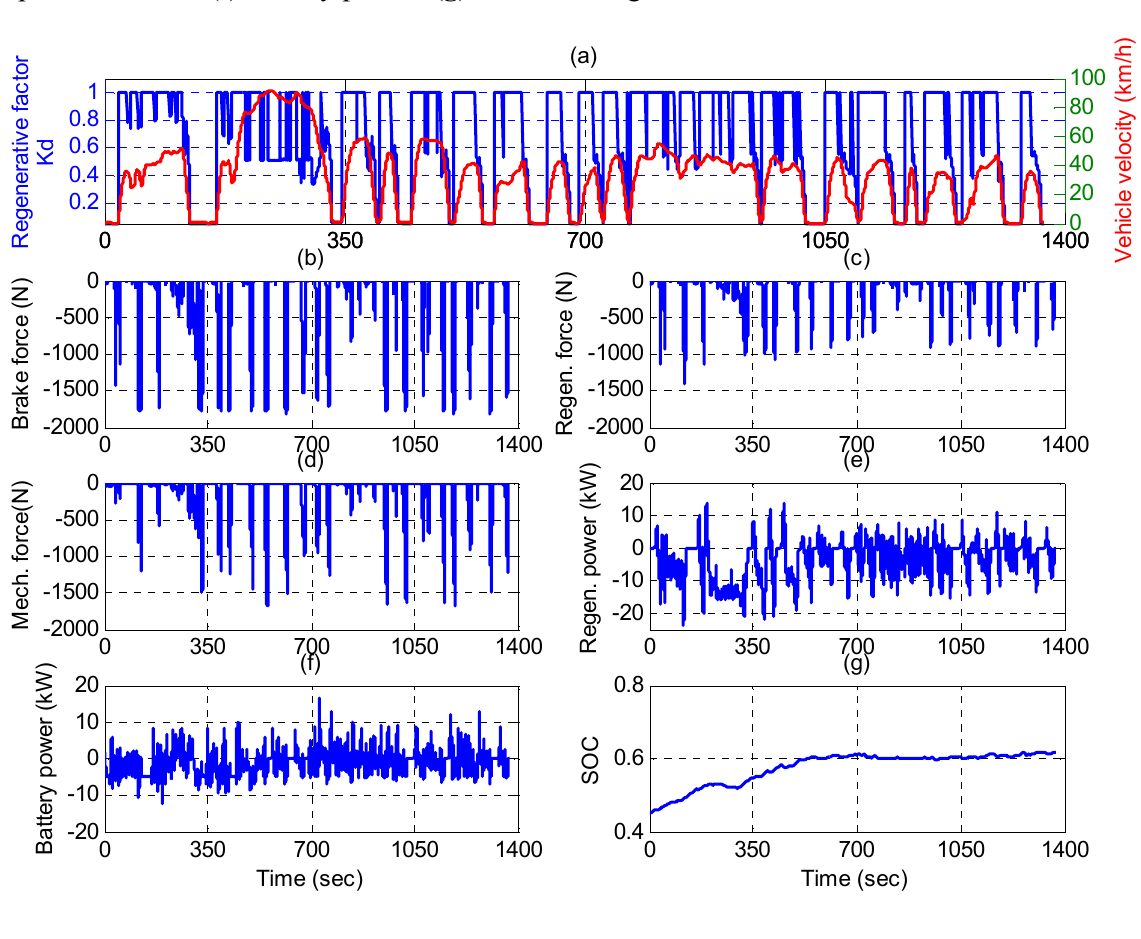
Figure 14. Simulation results of the FL regenerative braking controller for the PM-EVT-HEV during a UDDS: ( a ) UDDS and the regenerative factor; ( b ) Total braking force; ( c ) Regenerative force by EM2; ( d ) Mechanical braking force; ( e ) Regenerative power of EM2; ( f ) Battery power; ( g ) State of charge,